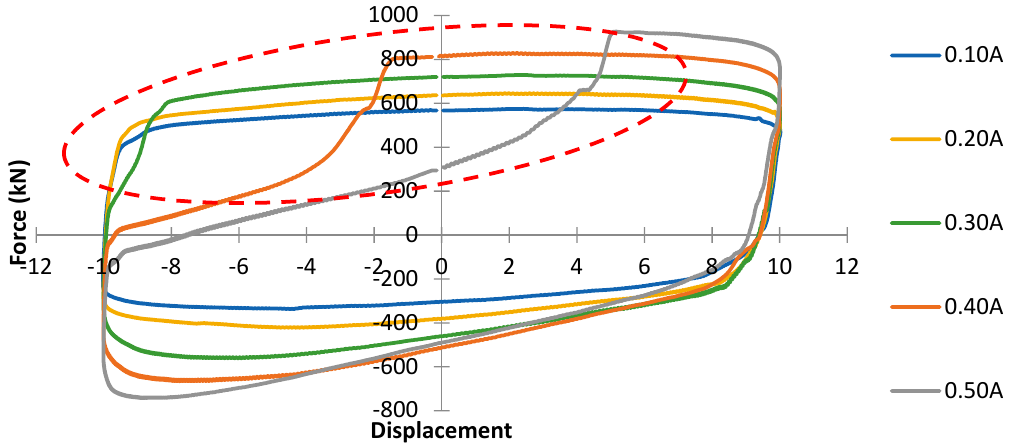
Figure 20. Void-like effect on the damping force of MR damper at higher current (measured).